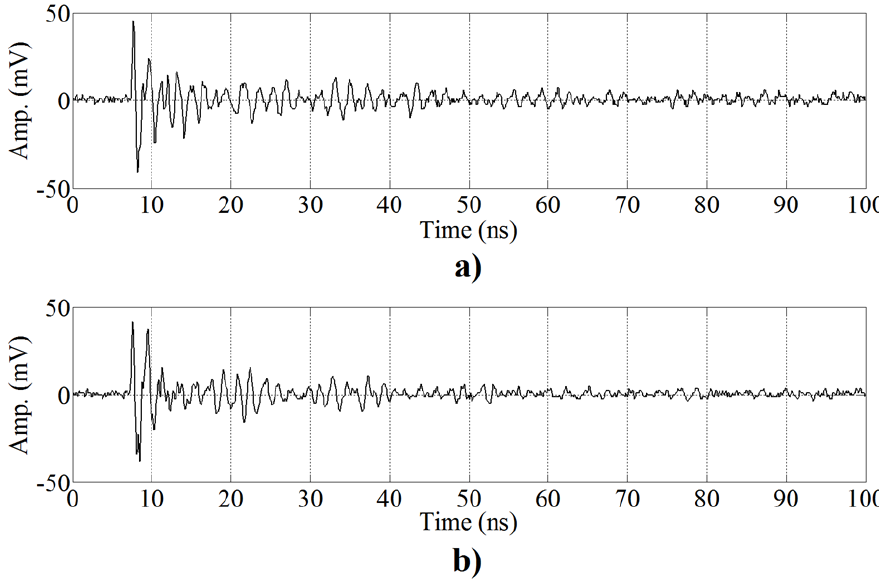
Figure 4. Representative UHF signals from the two surface test objects. ( a ) s 1 ( t ) and ( b ) s 2 ( t ) .